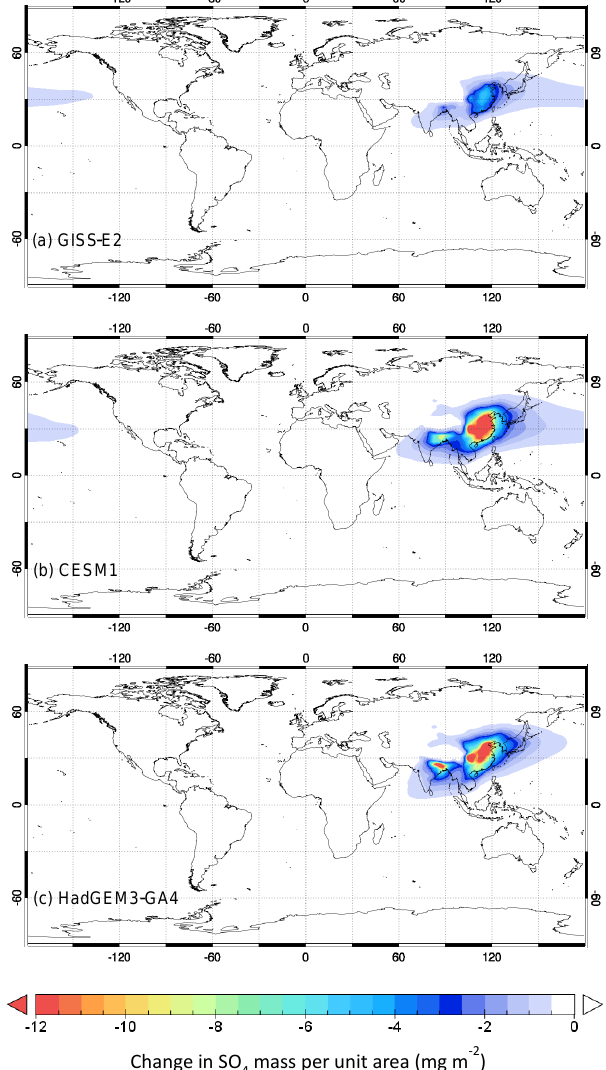
Change in SO mass per unit area (mg m -2 ) 4 Figure 3. Global changes in column-integrated SO 4 burden due to removing anthropogenic SO 2 emissions from China for (a) GISS- E2, (b) CESM1, and (c) HadGEM3-GA4. Differences are calcu- lated as perturbation simulation minus control simulation, averaged over 150